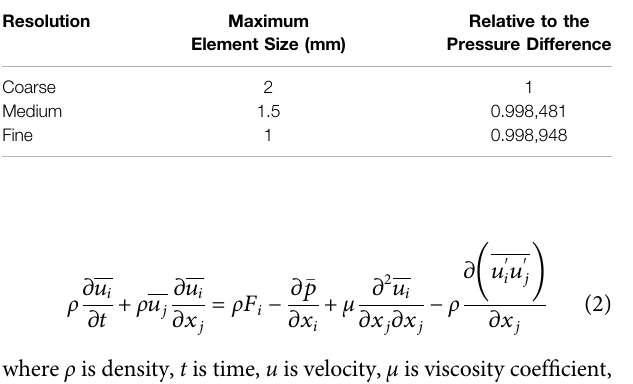
TABLE 1 | Results of the mesh-independence test.